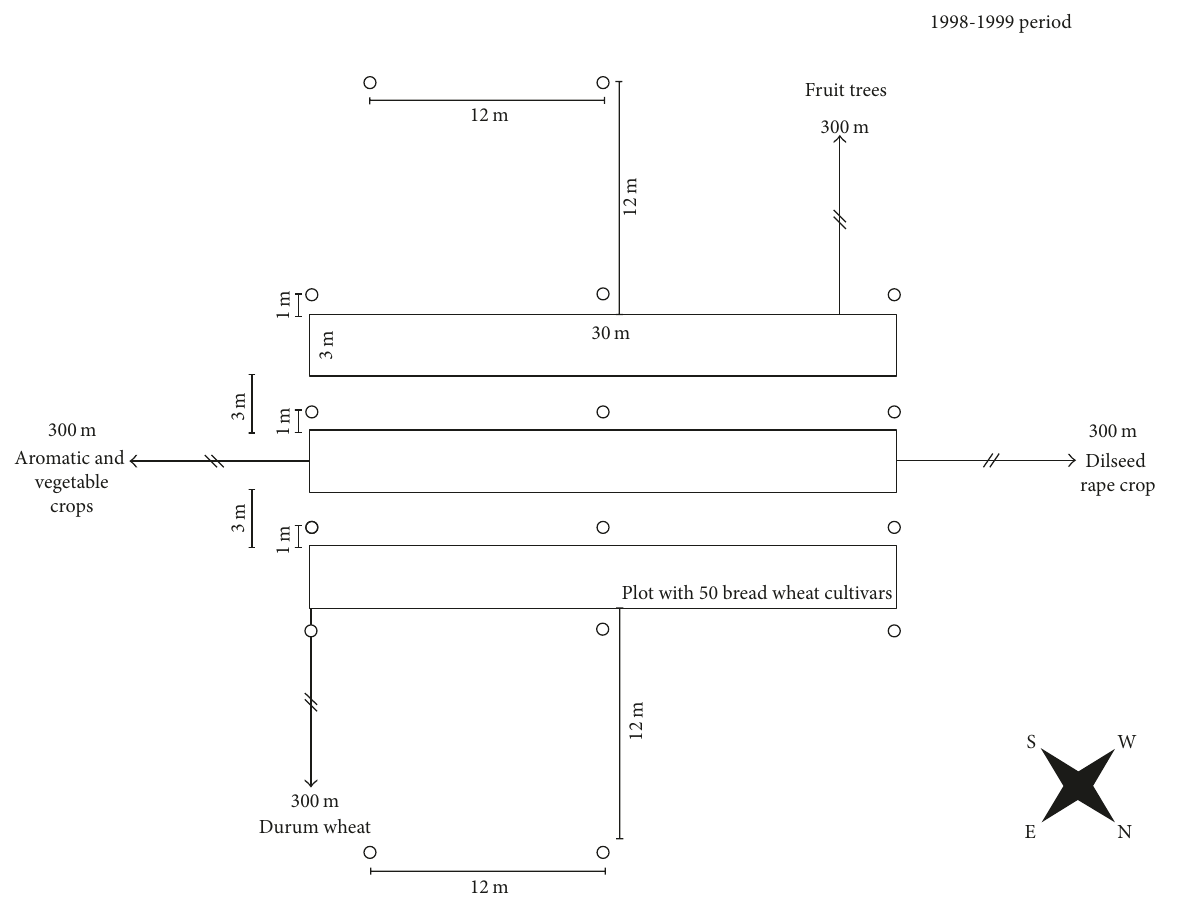
Figure 1: Spatial diagram of the traps arrangement: 1998-1999